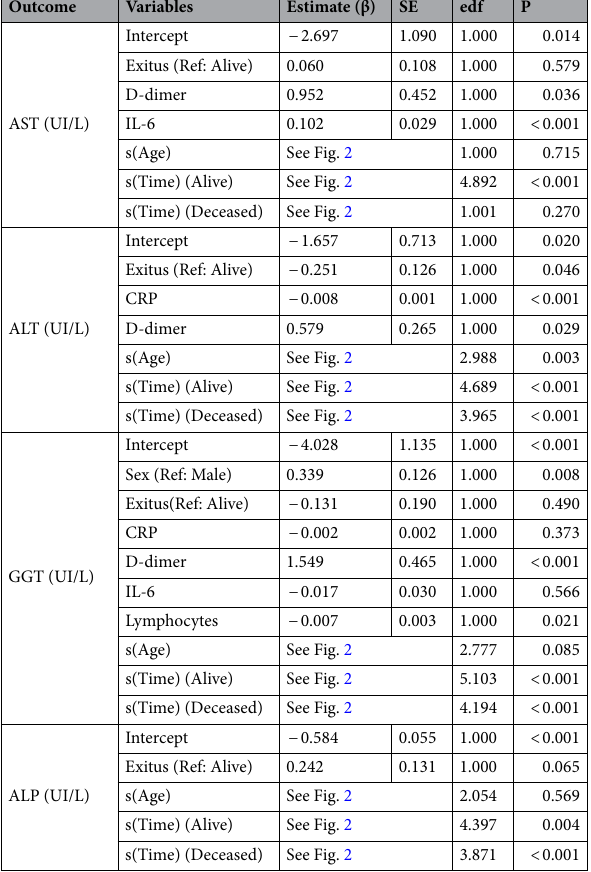
Table 3. Results for the multivariate regression models for the weighted and Box–Cox-transformed values of transaminases. SE means standard error. The edf number represents the parameters needed to estimate the effect of a covariate, indicating the complexity of the functional form of the smooth